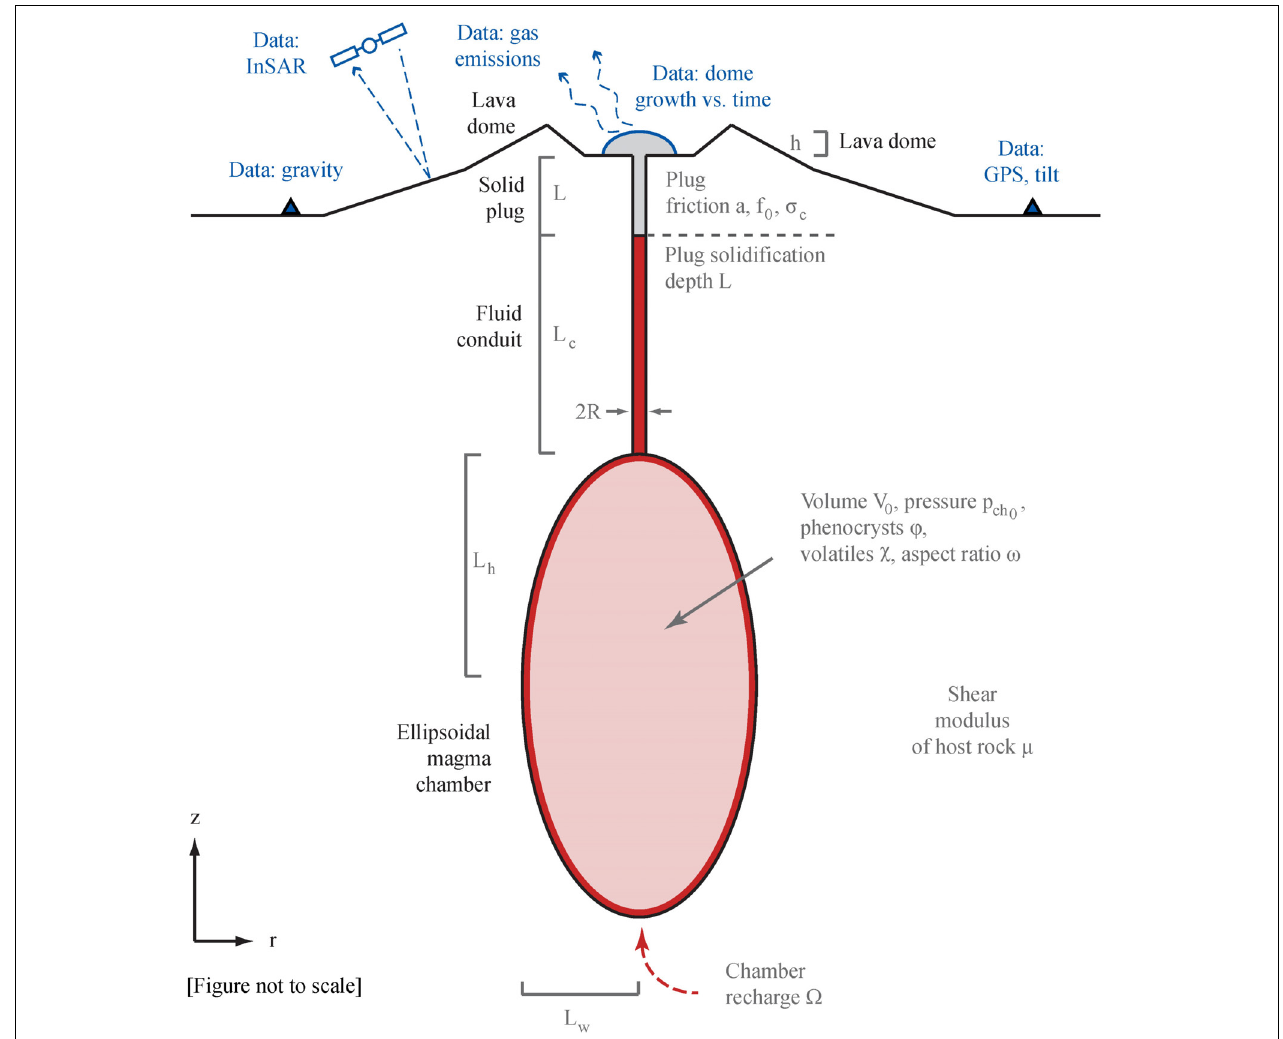
FIGURE 10 | Physics-based model of the Mount St. Helens magmatic system, reproduced from Anderson and Segall (2011).